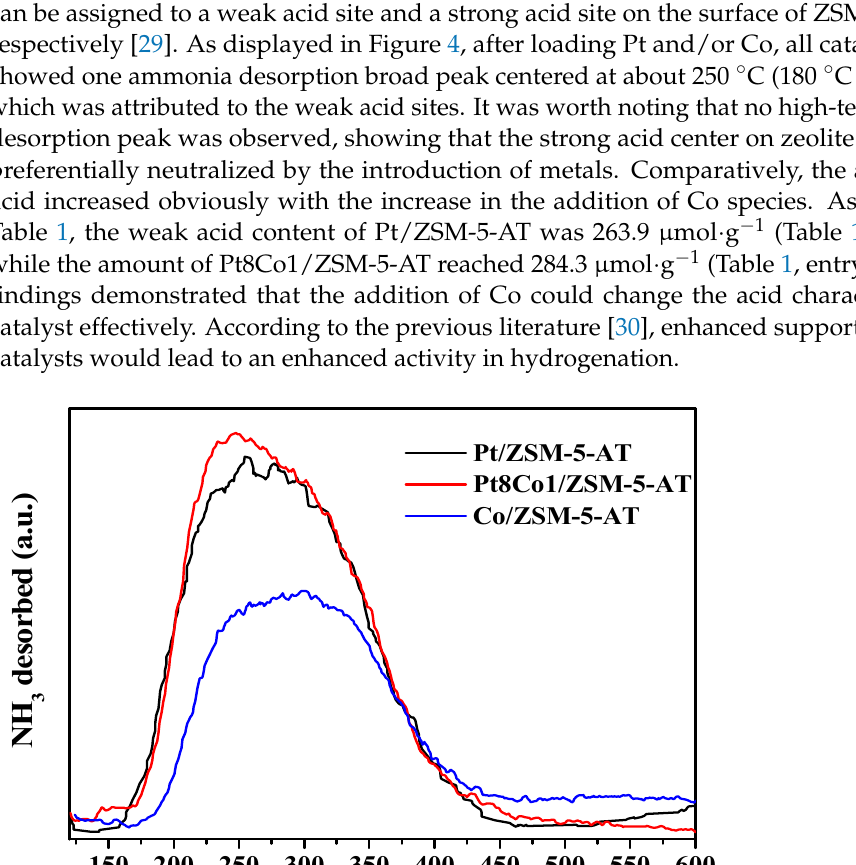
Figure 3. The N 2 adsorption–desorption curve ( a ) and pore diameter distribution ( b ) of the as-prepared Pt8Co1/ZSM-5-AT, Pt/ZSM-5-AT and Co/ZSM-5-AT catalysts.